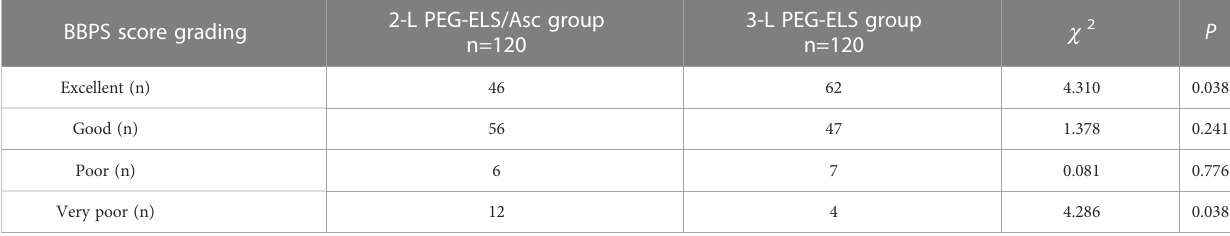
TABLE 3 Comparison of BBPS score grading between the two